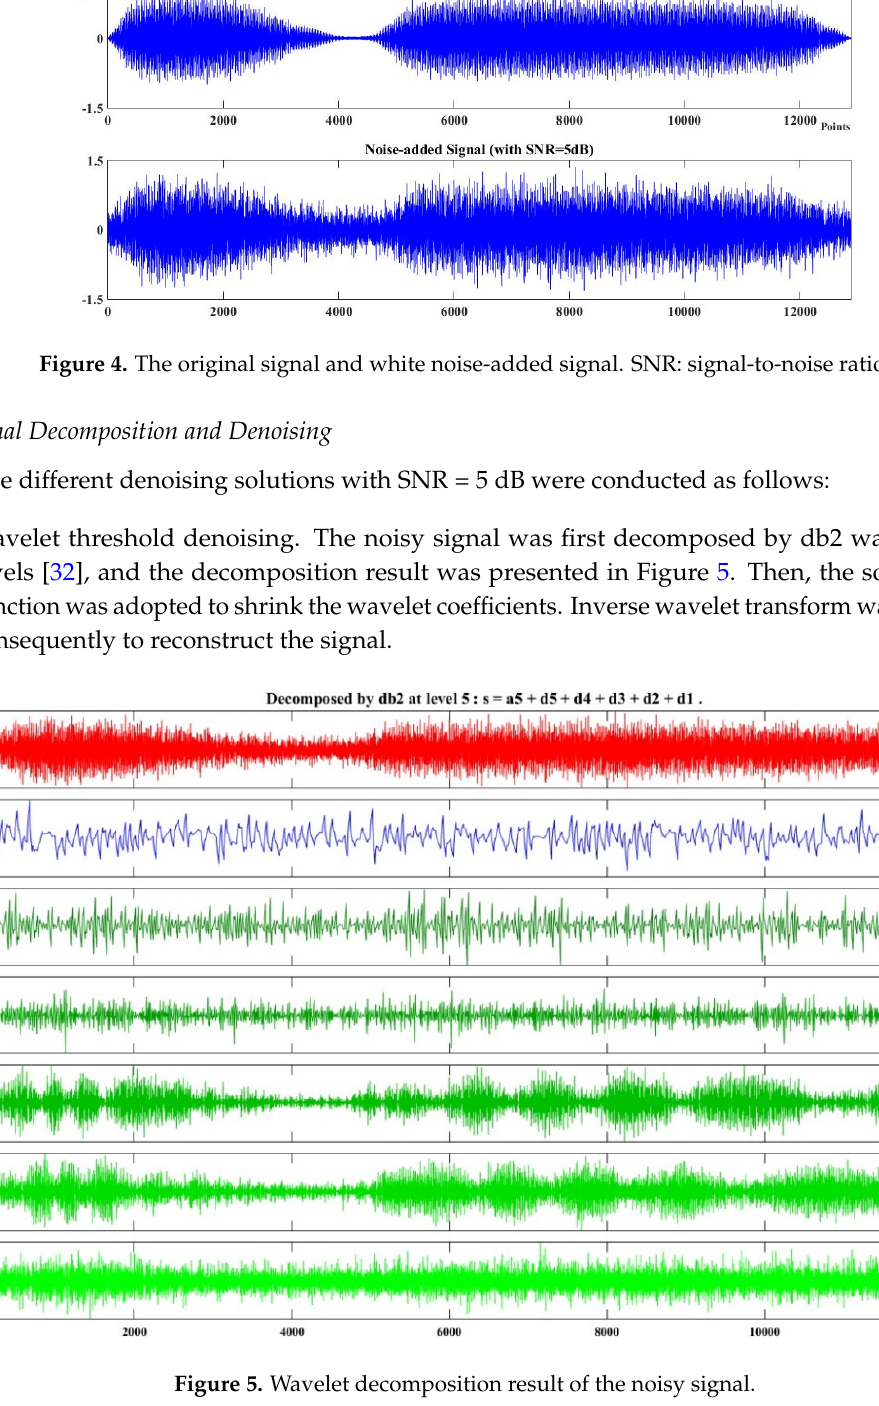
Figure 6. Empirical mode decomposition (EMD) result of the noisy signal. IMF: intrinsic mode function. (3) EMD ‐ PSO denoising. The noisy signal was first decomposed by EMD adaptively. Then, the threshold of each IMF was determined according to PSO intelligently. Soft threshold function was applied and the denoised signal was reconstructed as Equation (9). Some parameters during the EMD ‐ PSO were set as recommended in [23]: M 1 = 2, M 2 = 4, the dimensionality of